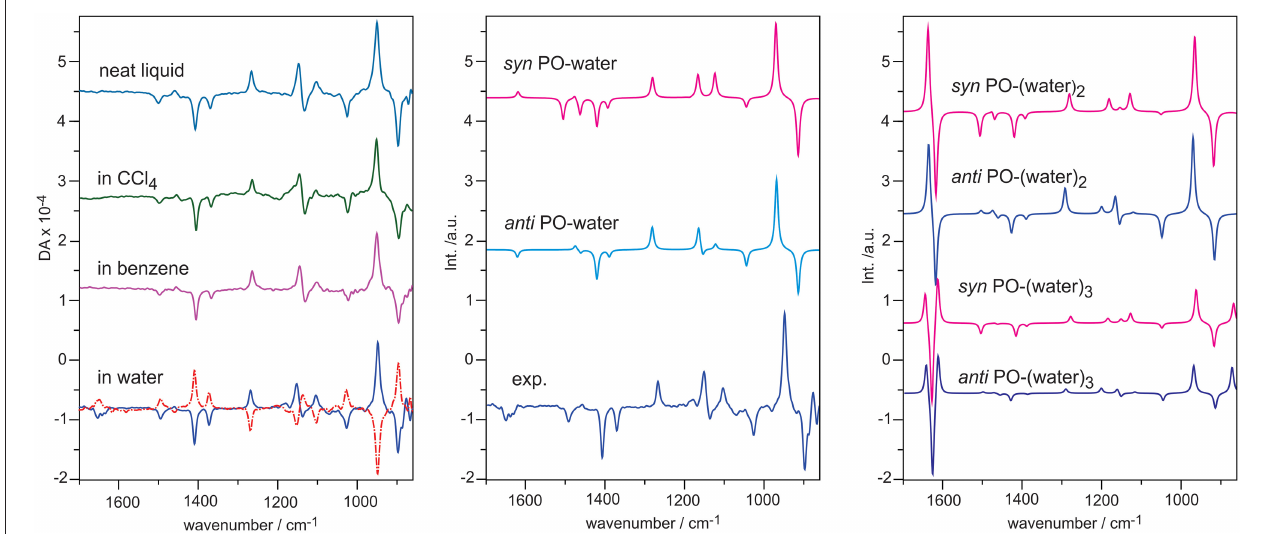
FIGURE 6 | Left: experimental VCD spectra of S -PO as neat liquid, in CCl 4 , in benzene, and in water. Dotted line indicates measurement with R -PO. Middle : comparison of the experimental VCD of S -PO in water with the simulated VCD spectra of the anti and syn PO-water complex. Right : simulated VCD spectra of the two most stable conformers of PO-(water) 2 , 3 . Reproduced with permission from Losada et al. (2008a). Copyright 2008, American Chemical Society.